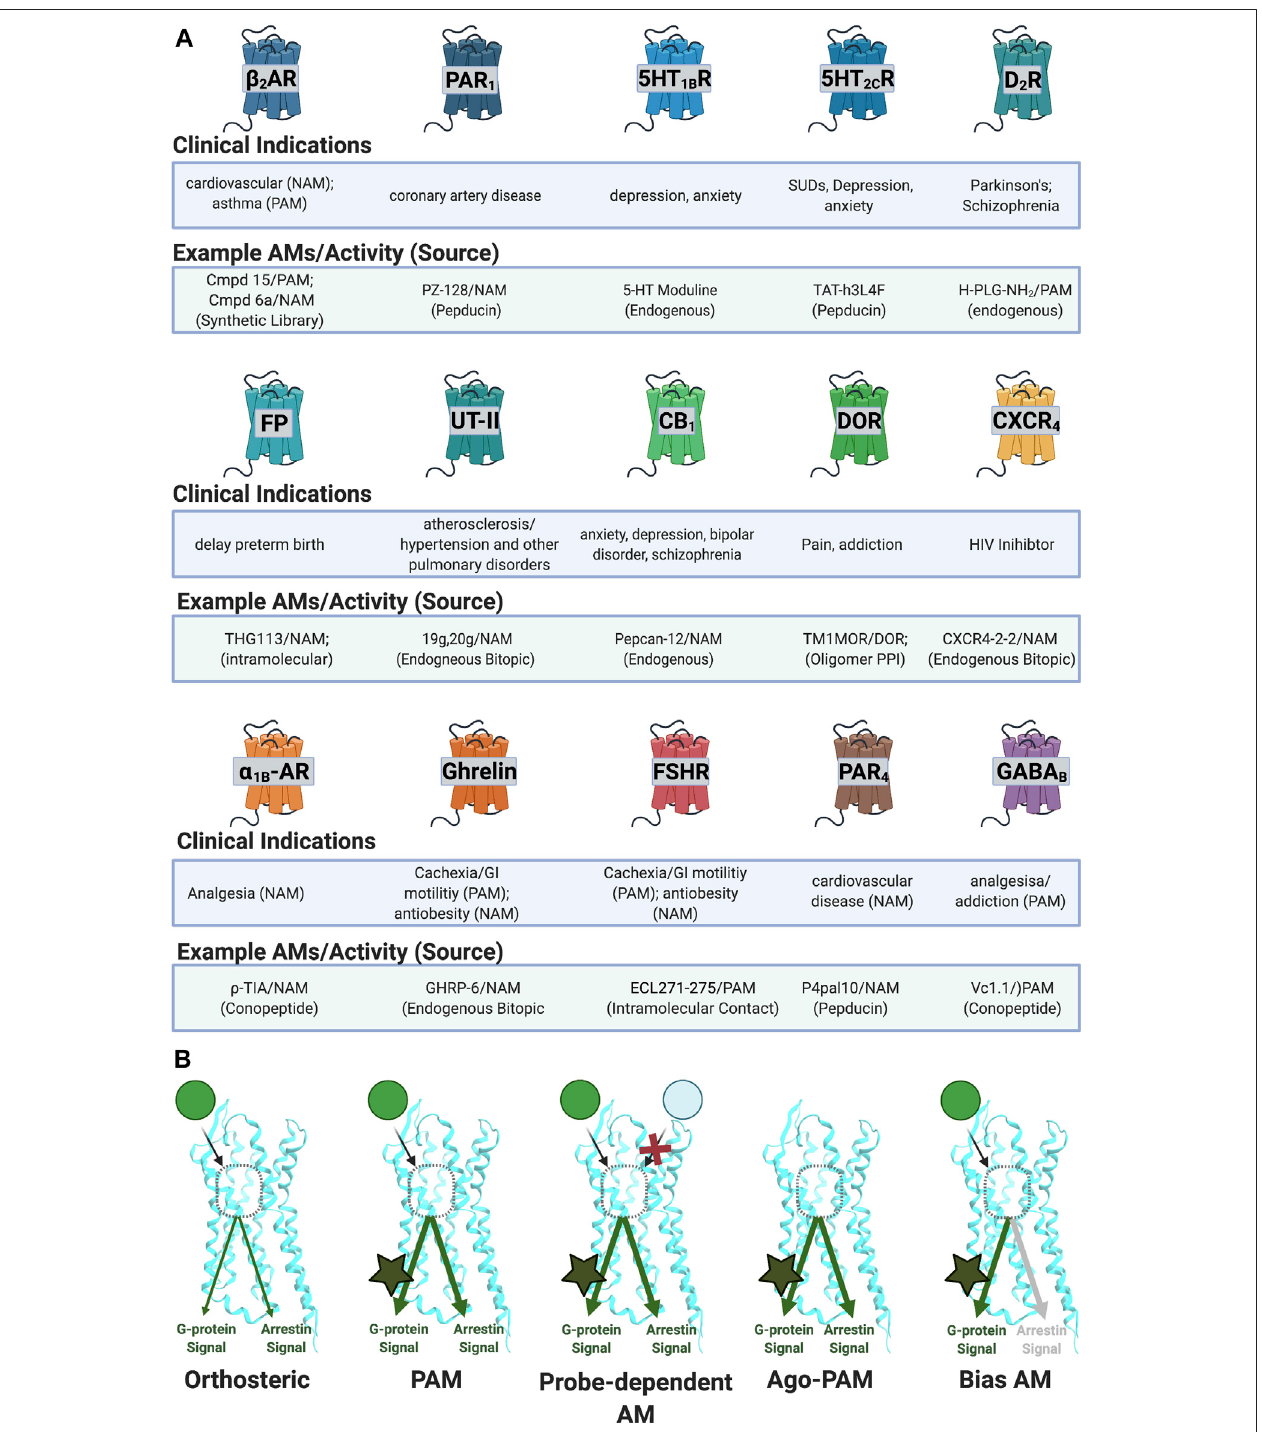
FIGURE4| ReportedAMtargetsforpeptide/peptidomimeticstherapeutics. (A) Sampleofclinicalindicationsofpeptidomimeticsdiscussedinthisreview. (B) AMs can produce variousbiological pro fi les. (Left) PAMs potentiate signals regardless of ligand or downstream mechanism. (Middle left) probe-dependent AMs potentiate the effects of one agonist (e.g., green) but not another agonist (e.g., light blue). (Middle right) ago-PAMs activate the receptor in the absence of an orthosteric ligand. (Right) bias-AMspreferentiallyactivateonesetofsignalingpathwaysoveranother,eitherinthepresenceofanorthostericagonistorasanago-PAM,includingbut not limited to G α versus β -arrestin signaling. Figure was created with BioRender.com. 1